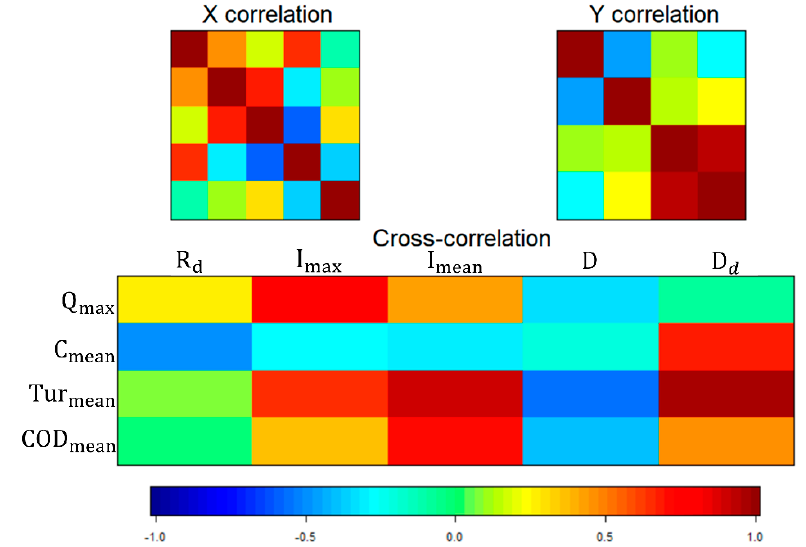
Figure A4. Correlation between rainfall and the CSO variables in the Multifamiliares CSO. The range